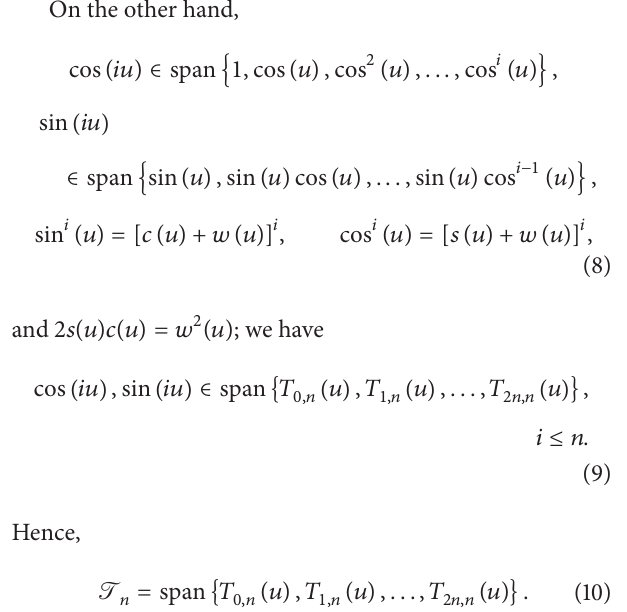
Table 1: The coefficients {𝑎 𝑖,𝑛 } of the trigonometric